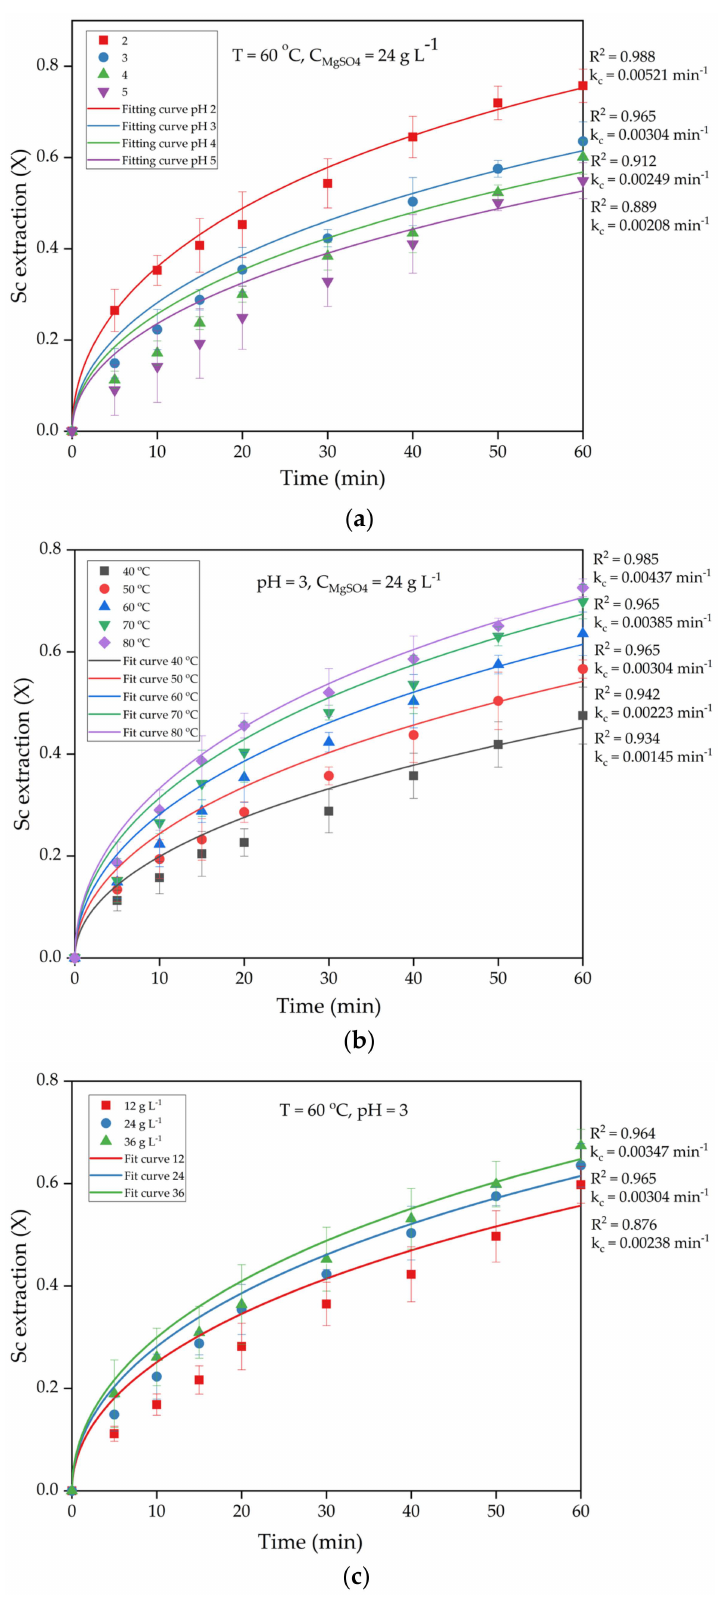
Figure 5. Effect of leaching parameters on extraction of Sc: ( a ) effect of pH; ( b ) effect of temperature; ( c ) effect of MgSO 4